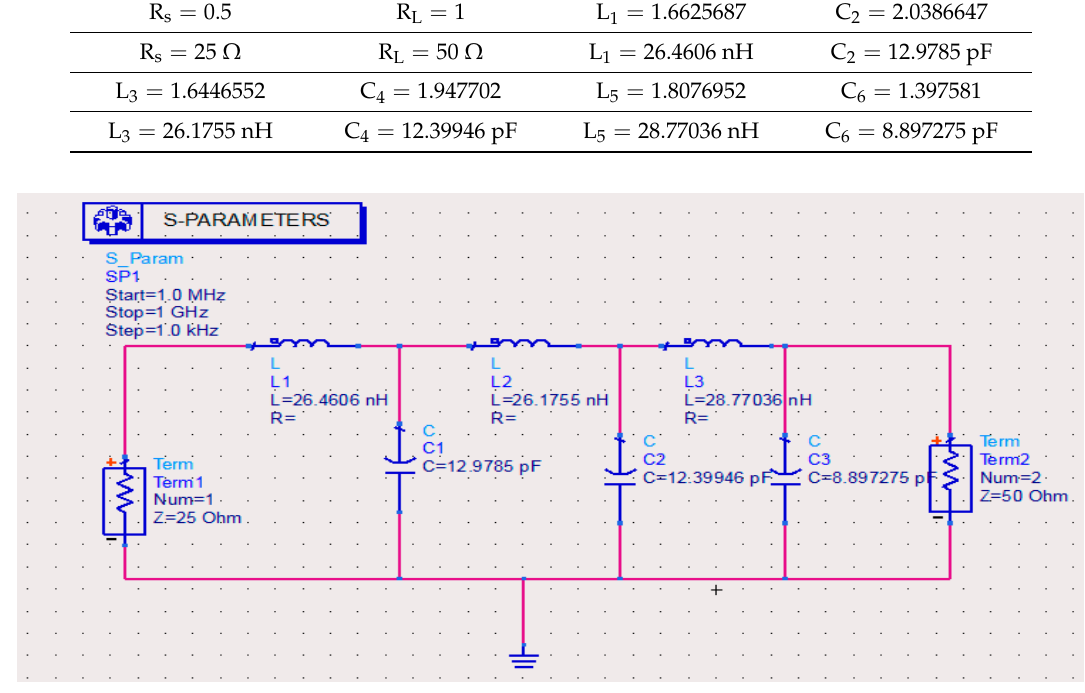
Figure 5. Low-pass filter with de-normalized passive elements simulated in ADS 2011.